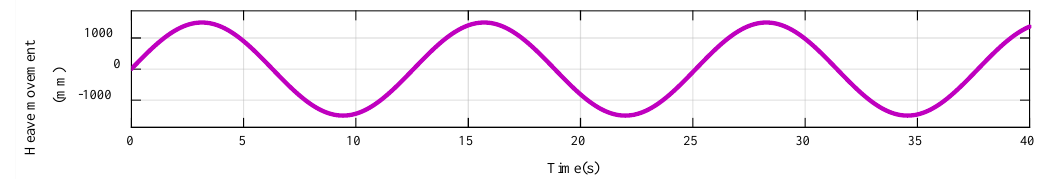
Figure 23. Heave movement of vessel.